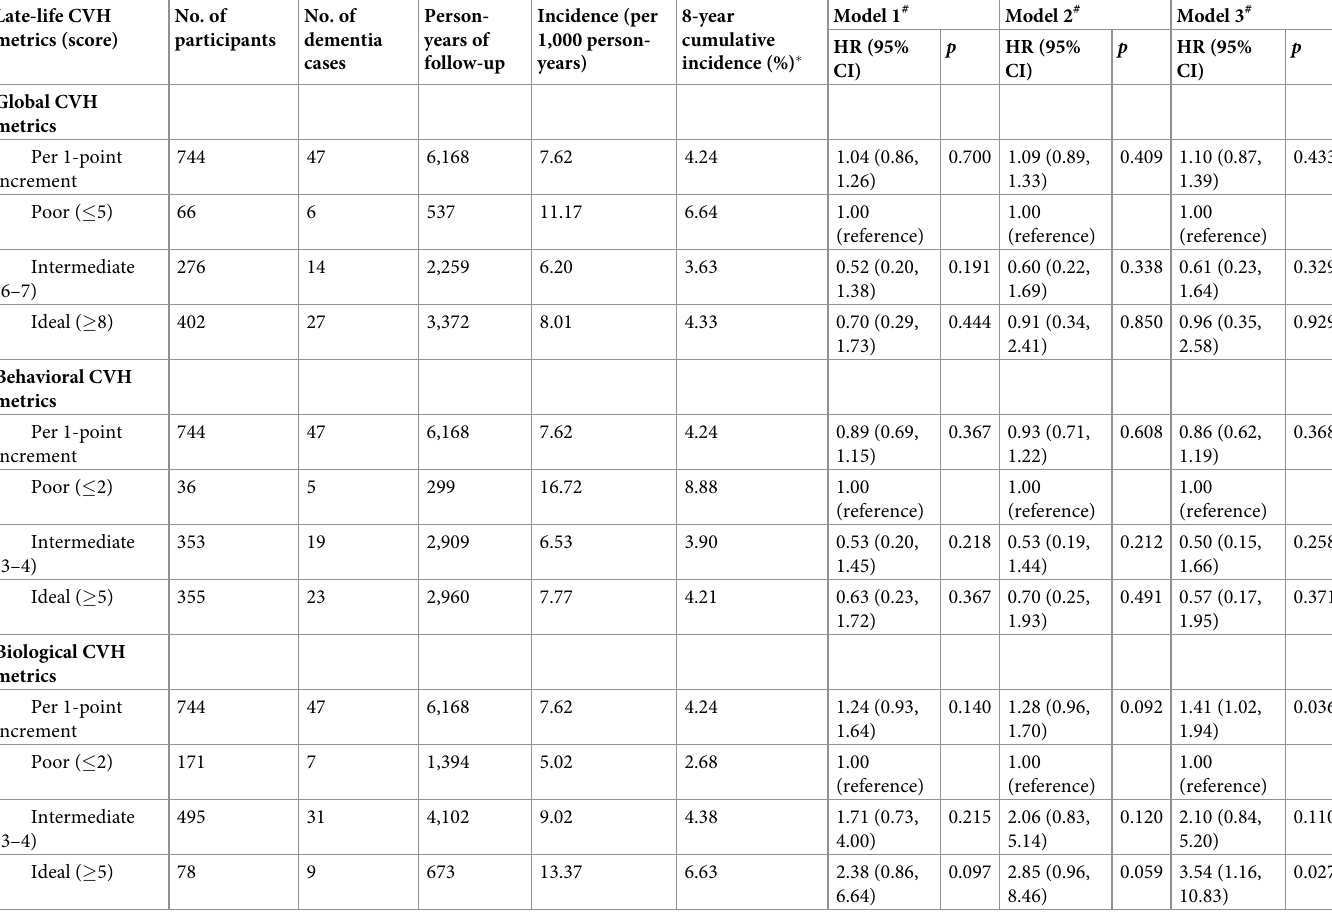
Table 4. The association of CVH metrics in late life (1998) and risk of dementia detected in late life (2005 to 2008) ( n = 744). Late-life CVH metrics